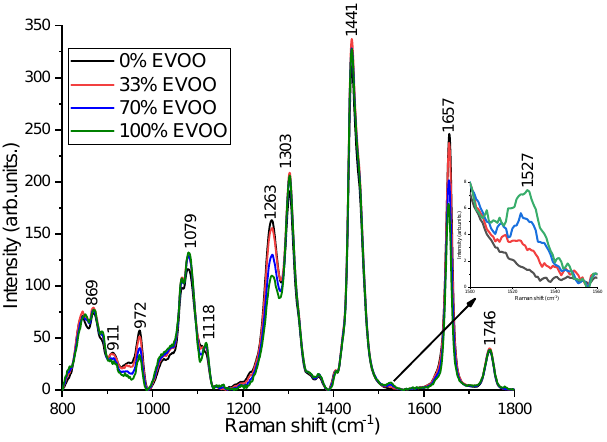
Figure 3. Raman spectra of EVOO adulterated with rapeseed oil, soybean oil and corn oil with different volume percentage. Inlet: The characteristic peak of EVOO at 1527 cm − 1 is enlarged for better visualization.